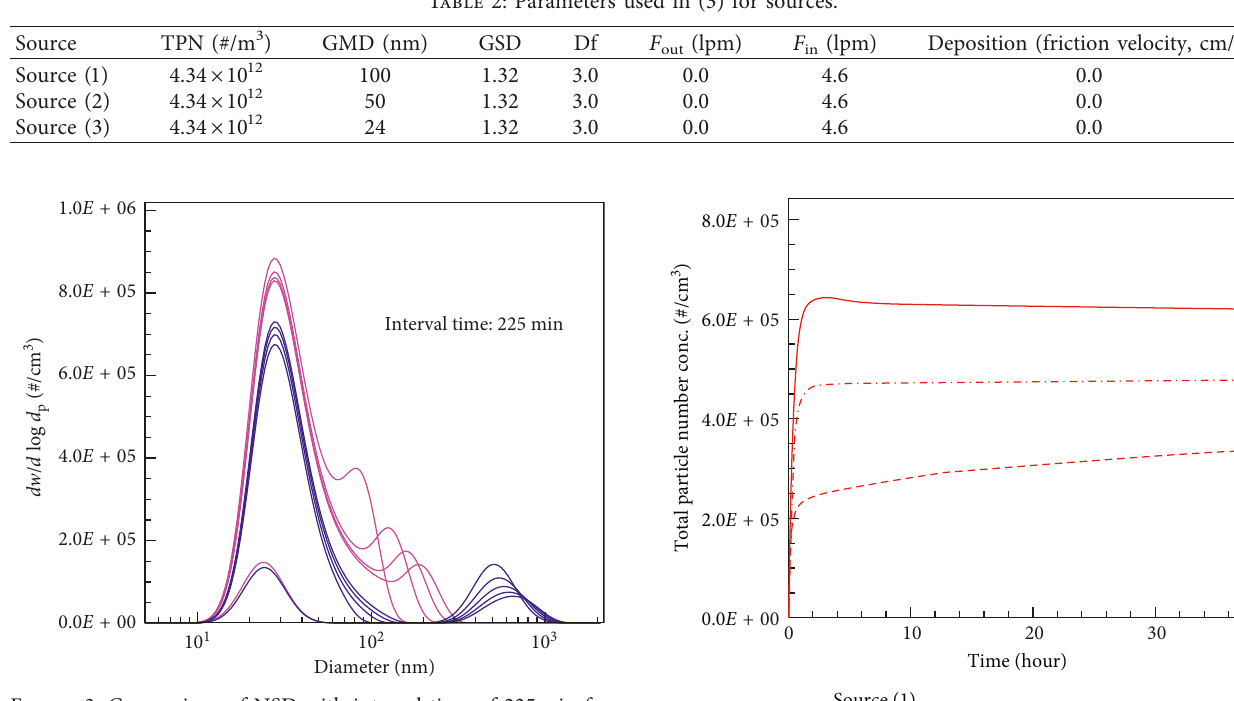
Figure 3: Comparison of NSD with interval time of 225min for source (1) in Table 2 with (blue) and without background particles (purple). In the calculation, only coagulation is considered.